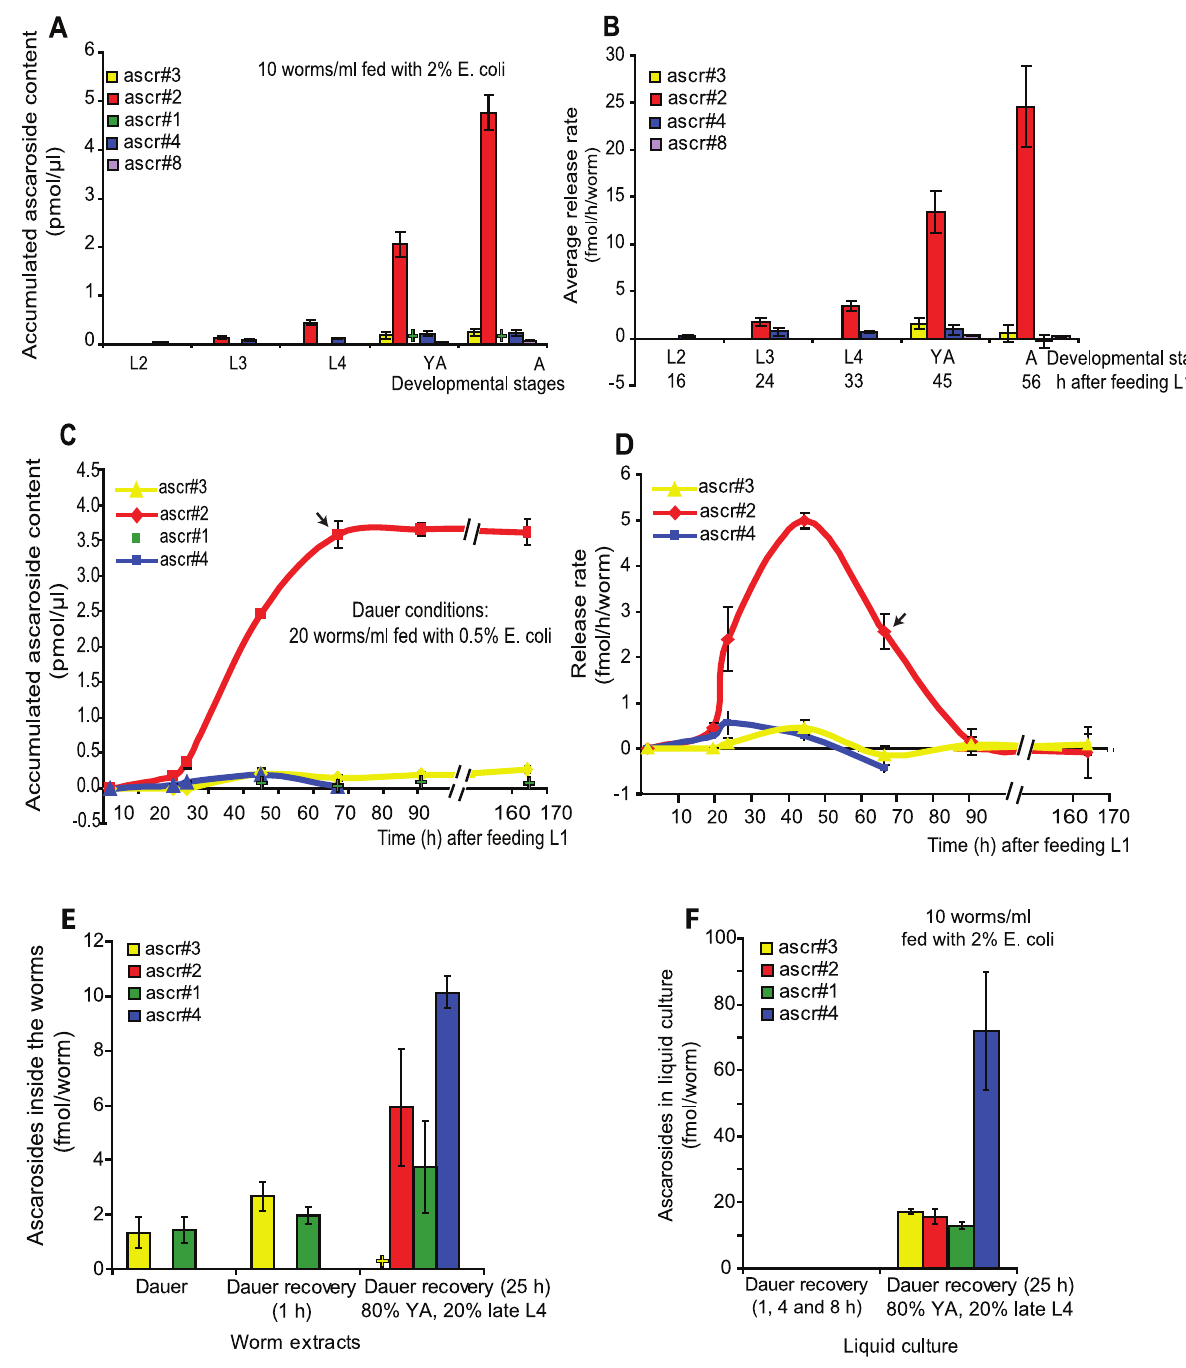
Figure 3. Changes in C.elegans ascaroside production during development in standard and dauer forming liquid cultures. Ascaroside concentrations were determined via LC-MS analyses in positive ion mode for ascr # 2 and ascr # 4 and negative ion mode for ascr # 1, ascr # 3, ascr # 7 and ascr # 8. (A) Concentrations of ascr # 2, ascr # 3, ascr # 4, and ascr # 8 in media samples taken from synchronized standard liquid cultures of L2, L3, L4, YA and adults with 10–15 eggs in standard liquid cultures (10,000 worms/ml fed with 2% E. coli ). The figure represents the mean of four experiments and error bars, s.e.m. (B) Average release rate calculated as changes in concentration (after each life stage transition subtracting the concentrations determined for the previous life stage) divided by the worm density and the number of hours since previous sampling. (C) Concentration of ascr # 2, ascr # 3, and ascr # 4 during dauer forming liquid cultures (20,000 worms/ml fed with 0.5% E. coli ). Ascr # 3 values were calculated from LC-MS analysis run positive ion mode. Ascr # 1 was detectable but not quantifiable. The figure represents the mean of four experiments and error bars, s.e.m. (D) Release rate, calculated by subtracting the concentrations determined for the previous time point and divided by the hours and worm density. Arrow at 67 h marks the time point at which 60% of the worms were SDS resistant. ND, not detected. (E) Ascaroside content of whole-body extracts of dauer and dauer recovered worm. Data shown are mean values from two experiments for dauer worm extracts and three experiments for dauer recovery extracts. (F) Ascaroside content of liquid culture of dauer recovered worms. The figure represents the mean of four experiments and error bars, s.e.m. + , detectable but not quantifiable.